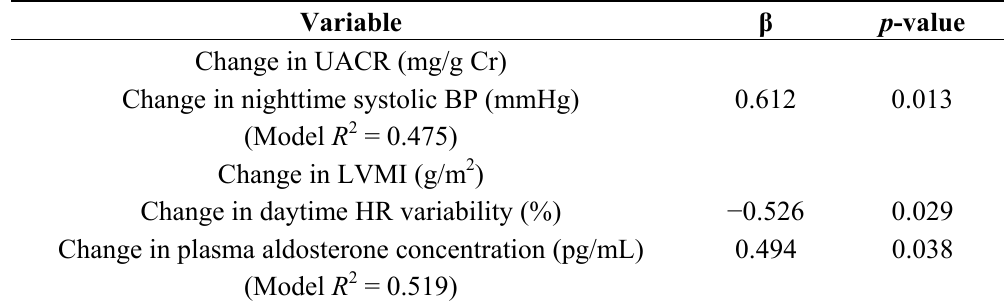
Table 7. Multivariate linear regression analyses of factors associated with changes in UACR and LVMI in the aliskiren add-on